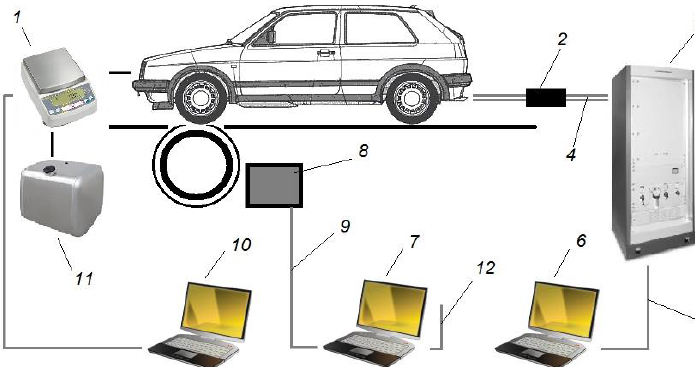
Figure 1. Schematic diagram of the setup used in tests. 1—Electronic scales; 2—heated filter;